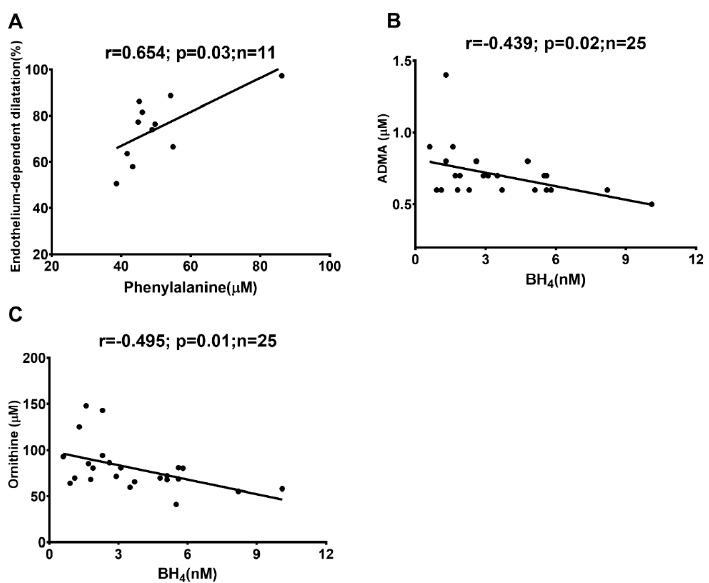
Figure 6. Spearman rank correlations between endothelium-mediated dilatation and phenylalanine (r = 0.654; p = 0.03; n = 11) ( A ), and BH 4 with ADMA (r = − 0.439; p = 0.02; n = 25) ( B ) and ornithine (r = − 0.495; p = 0.01; n = 25) ( C ), respectively, in patients with CKD-5 only. ADMA, BH 4 and ornithine were measured using chromatographic separation; the endothelium-dependent dilation was as- sessed using the ex vivo wire myograph technique. ADMA = asymmetric dimethylarginine; BH 4 =